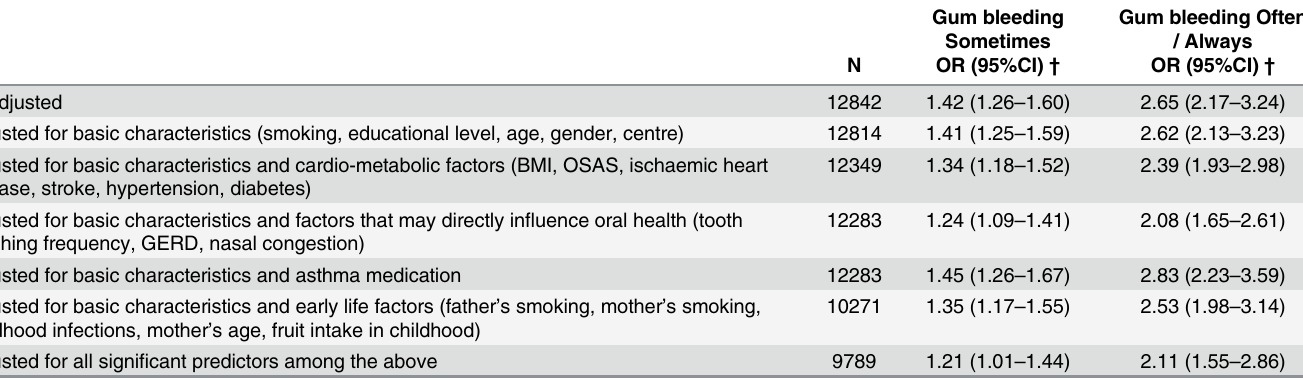
Table 4. Association of gum bleeding with (cid:1) 3 asthma symptoms * , adjusted for basic characteristics, metabolic factors, early life factors, factors directly affecting oral health, and all of